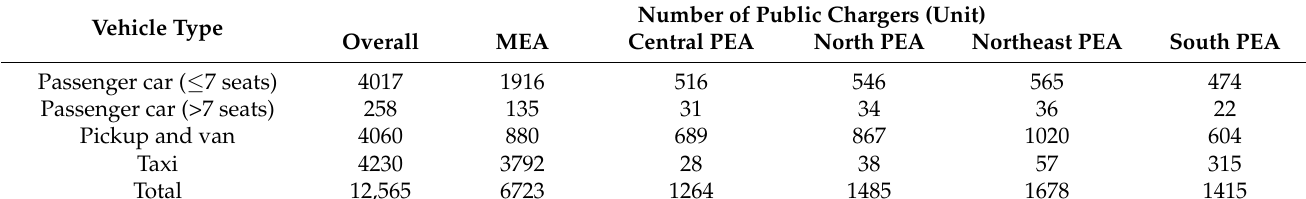
Table 4. Recommended number of public chargers.